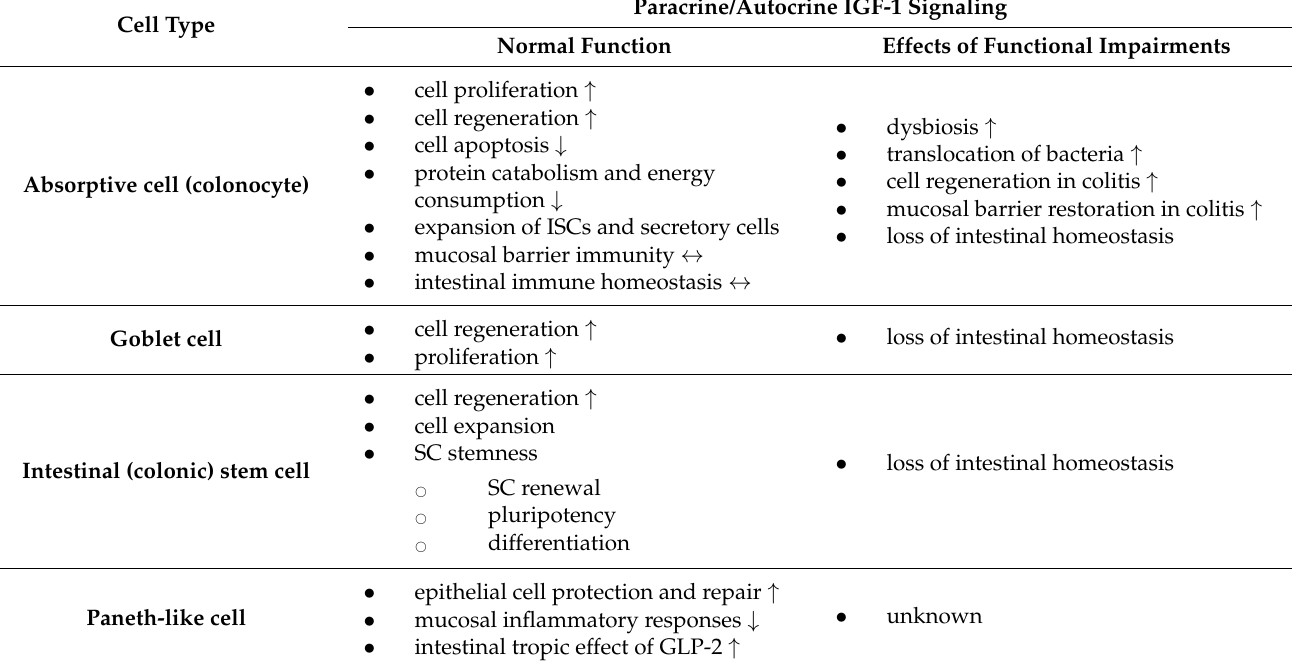
Table 2. Cell-specific normal and impaired functions of IGF-1 signaling in the colonic epithelial cells. Cell